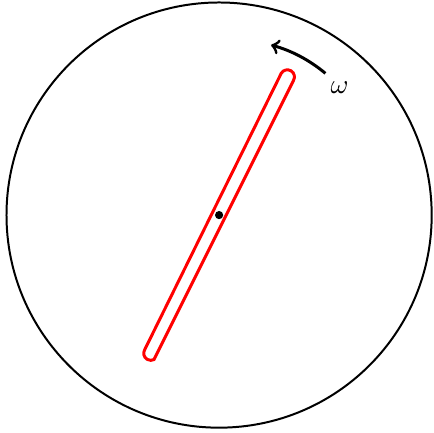
Figure 1 . A constant time slice of a folded classical string spinning around its center (the black dot) in AdS , with the black circle denoting the conformal boundary of AdS. Although we have drawn 3 the two segments of the string separated for demonstrative reasons, they in fact coincide. The string spins like a rigid rod, with both ends spinning at the speed of light, moving along null geodesics. string state of lowest energy E (equal to ∆ in AdS units) for given J is a folded string